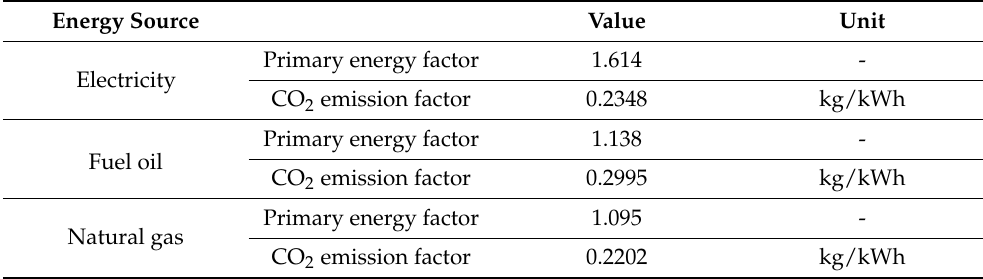
Table 5. Primary energy factors and CO 2 emission